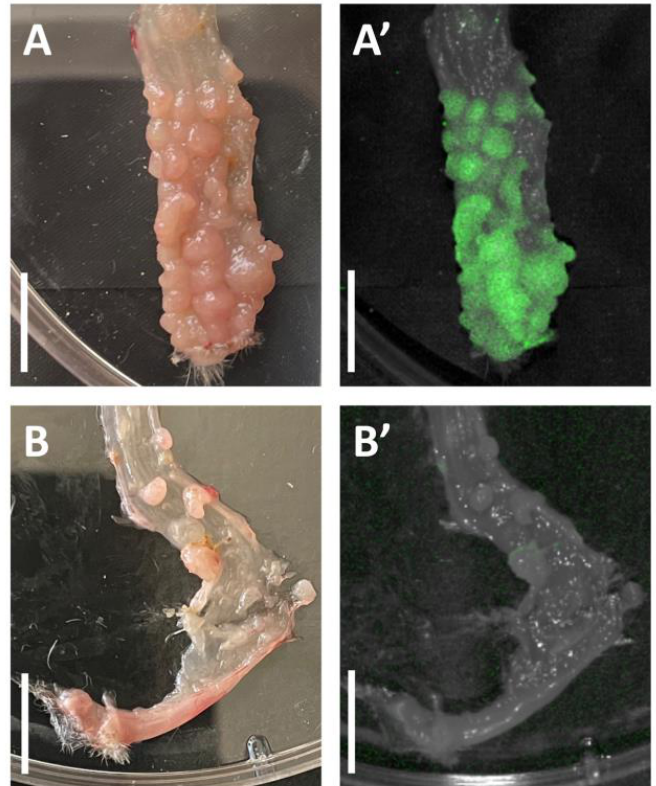
Figure 1. CPC-APC mouse colon (rectum at the bottom of image) opened longitudinally and imaged 48 h after administration of 150 μg MUC5AC-IR800 (panel ( A ) = bright light, panel ( A’ ) = NIR imaging) with specific labeling of polyps in NIR image. Compared to CPC-APC mouse colon opened longitudinally and imaged 48 h after administration of comparable moles of NIR dye as a control (panel ( B ) = bright light, panel ( B’ ) = NIR imaging). Scale bar: 1 cm.